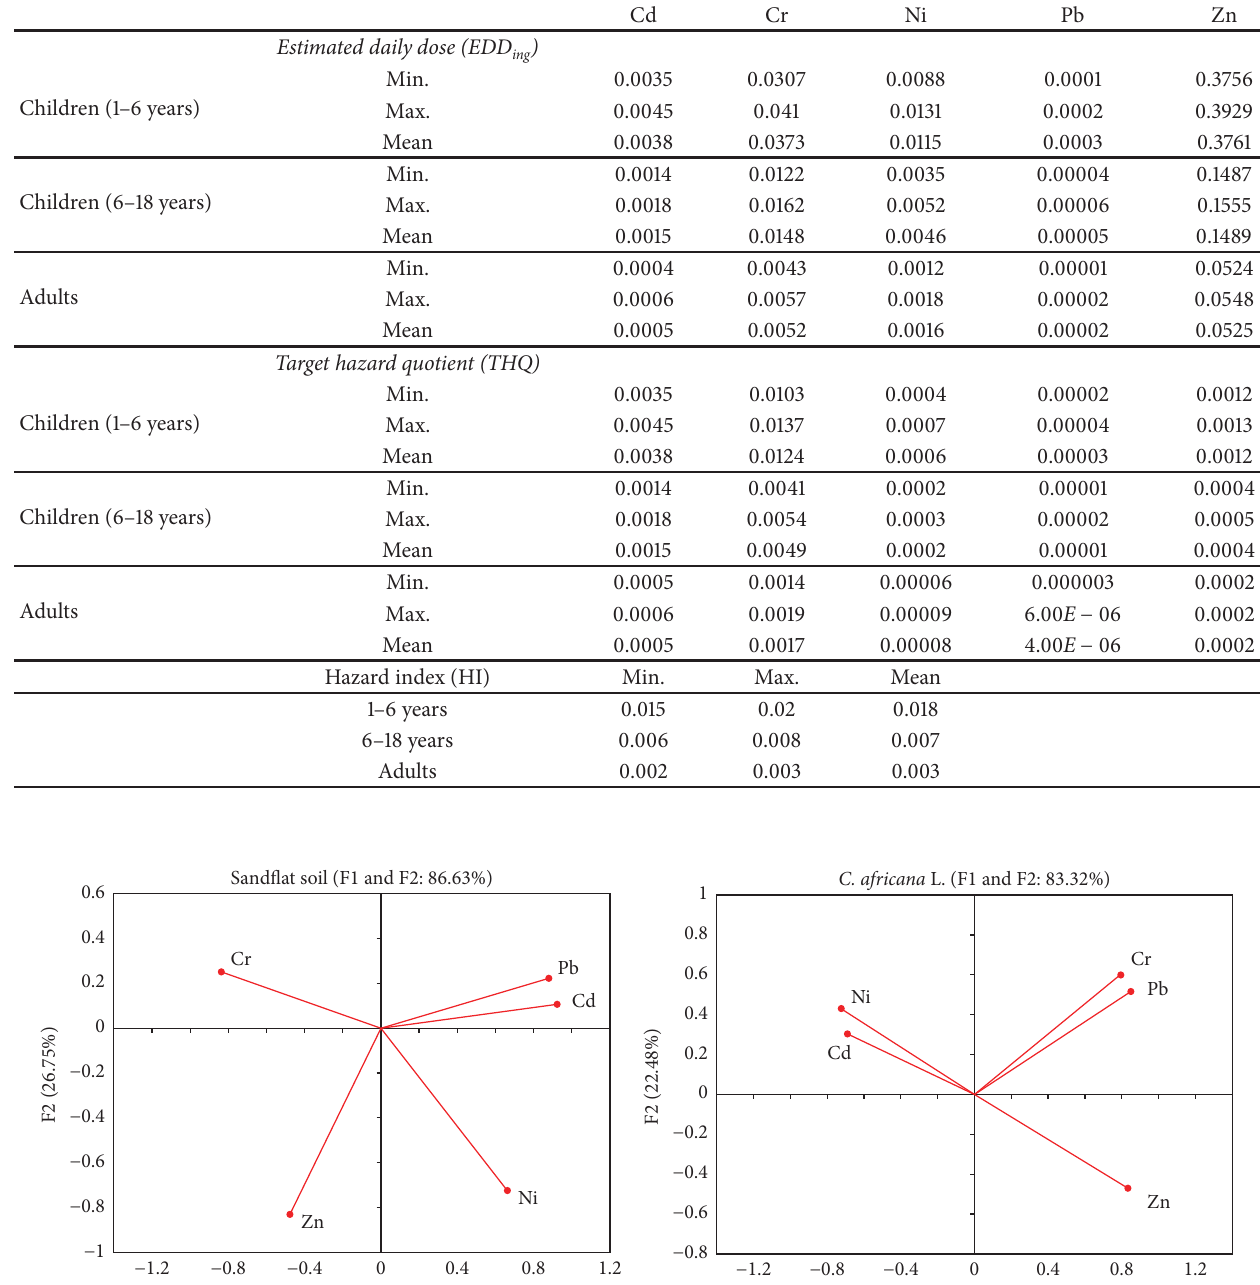
Table 7: Noncarcinogenic effects due to oral ingestion exposure to sandflat soil trace metals.